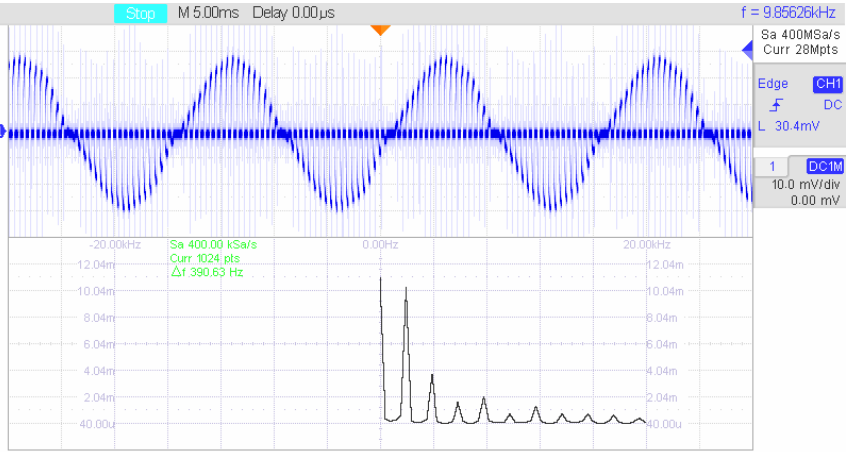
Figure 24. Load voltage spectrum.